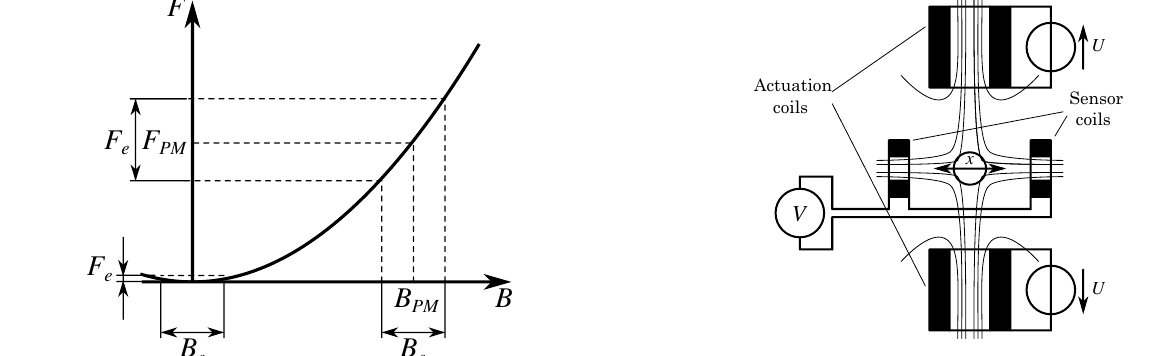
Figure 5. Quadratic dependency of the magnetic force on the flux density.